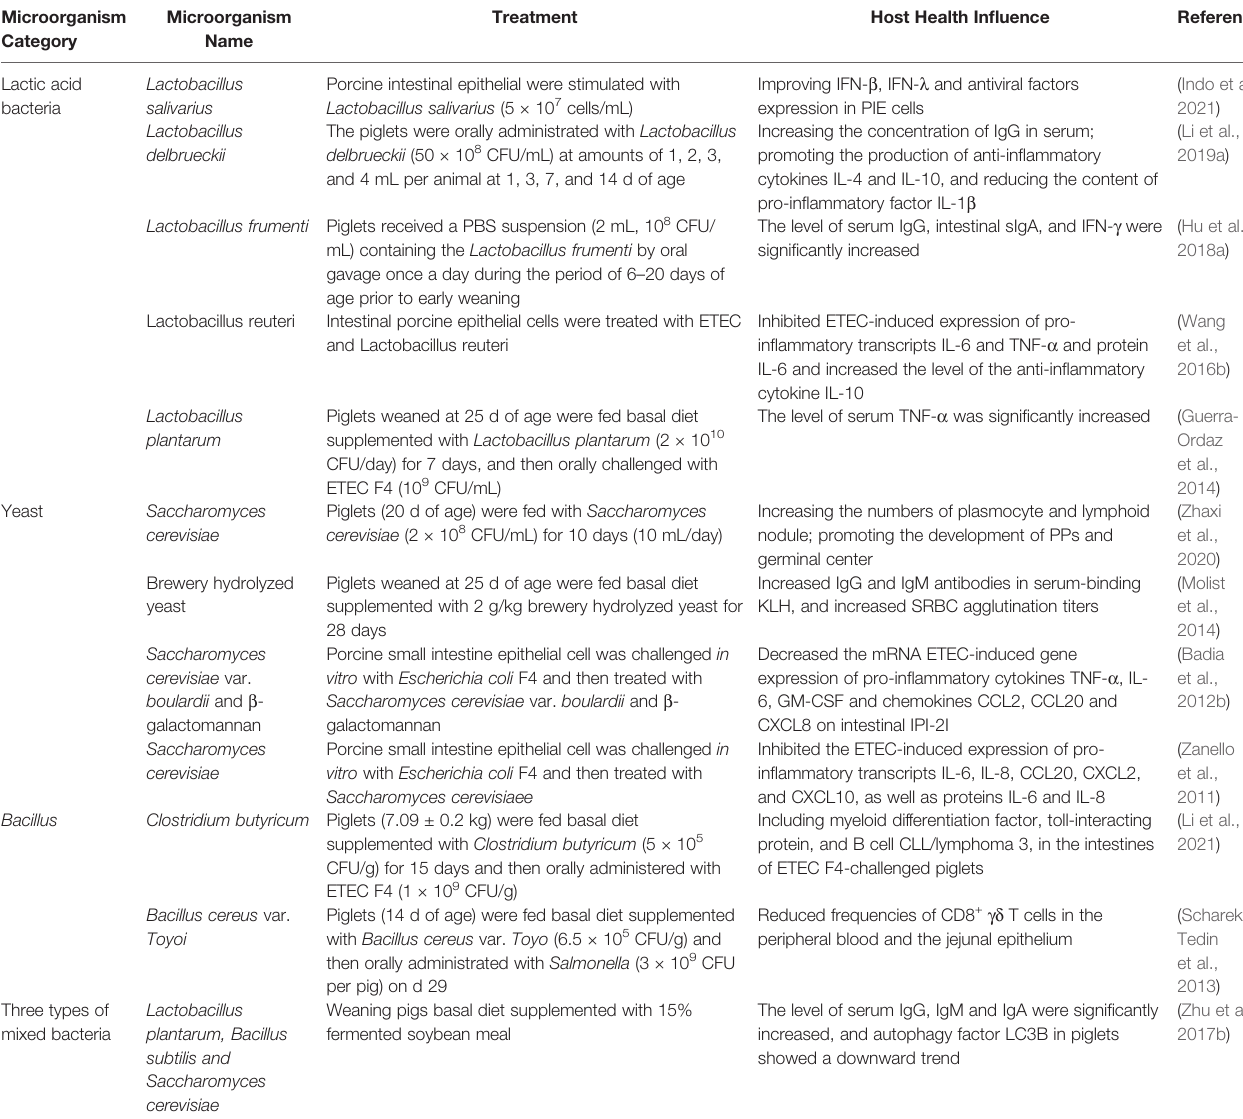
TABLE 2 | Effects of probiotics on immunity of